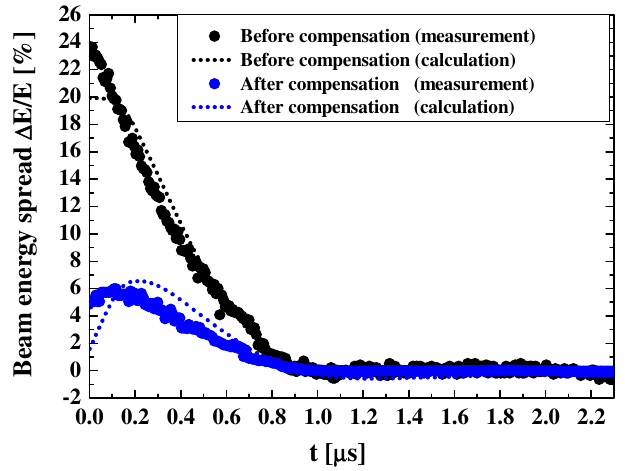
FIG. 17. (Color) Measured and calculated beam energies before (black) and after (blue) the initial-beam-loading compensation downstream of Acc3.